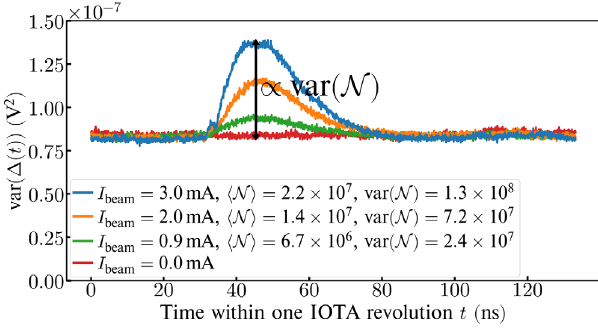
FIG. 5. The variance of Δ -signal as a function of time [see Eq. (22)] within one IOTA revolution (round-beam